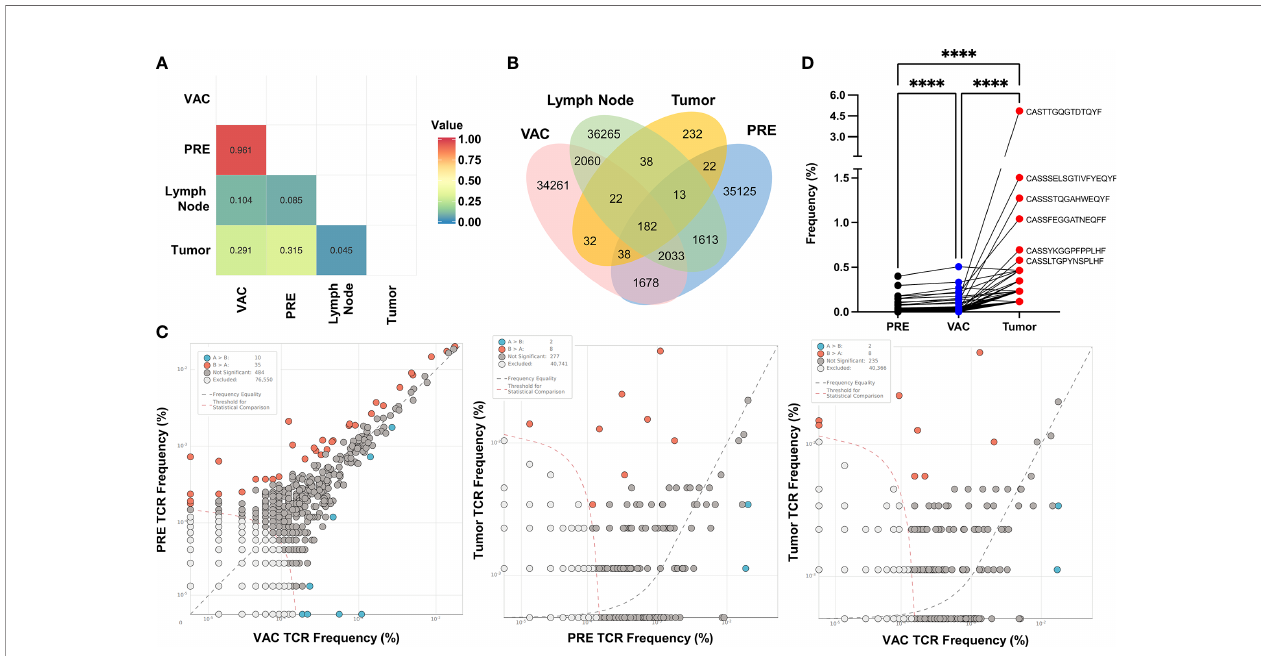
FIGURE 6 | CDR3 sequences found in tumor-in fi ltrating lymphocytes correlates with expansion of T cells in a patient after doxorubicin and cyclophosphamide (NAC-AC) plus dendritic cell (DC) treatment. (A) Similarity analysis of the CDR3 sequence by Morisita index 0 – 1 (no similarity to complete similarity, respectively) represented in a heat map. (B) Venn diagram showing the number of overlapping rearrangements present in the four sequenced samples [tumor, lymph node, and peripheral blood mononuclear cells (PBMCs) before and after NAC+DC vaccination]. (C) Scatter dot plot comparing the frequency of unique sequences with signi fi cant differences (increased or decreased) between samples (orange and blue dots), excluded sequences [white dots, below threshold (orange dashed line)] and nonsigni fi cant differences [gray dots, near frequency equality (black dashed line)]. (D) Paired comparison of the frequency of shared rearrangements among the three samples (n = 182), PRE (black dots), VAC (blue dots), and tumor (red dots). Top CDR3 sequences were denoted alongside the tumor CDR3 rearrangement. Parametric one-way ANOVA test with Turkey ’ s multiple comparison test among the three samples, ****p <